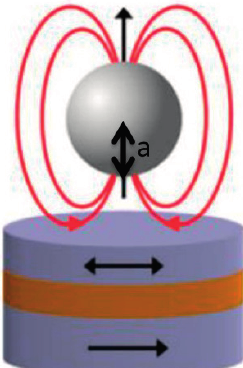
Figure 11. Out-of-plane magnetic field application for magnetic label sensing measurement